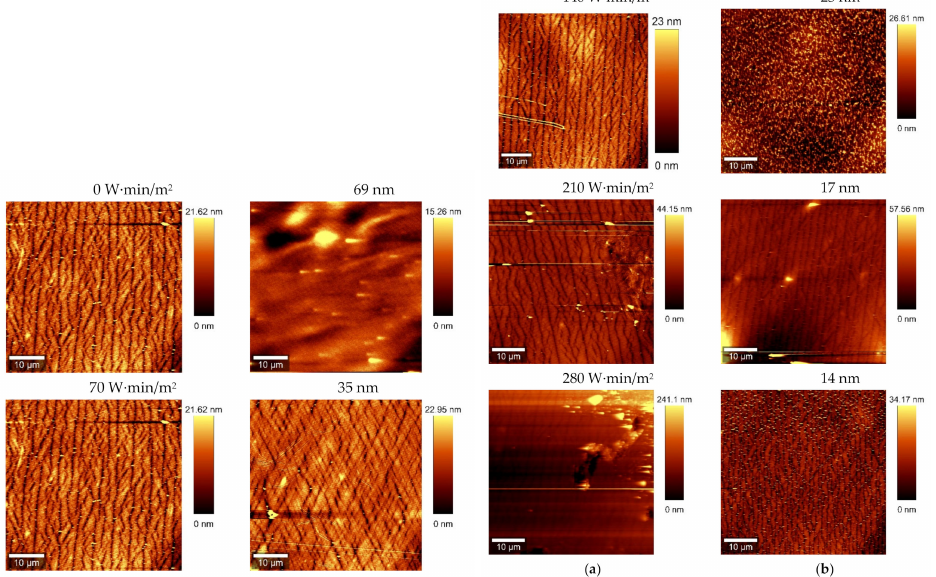
Figure 7. Atomic force microscopy images of PET samples coated with aluminum and subjected to 20% strain for ( a ) di ff erent corona dosages of 0–280 W · min / m 2 at a constant thickness of 14 nm and (Refers to Figure 5c at 20% strain) ( b ) di ff erent aluminum thicknesses of 14–69 nm at a corona dosage of 0 W · min / m 2 (Refers to Figure 6a at 20% strain). The vertical lines indicate cracks in the